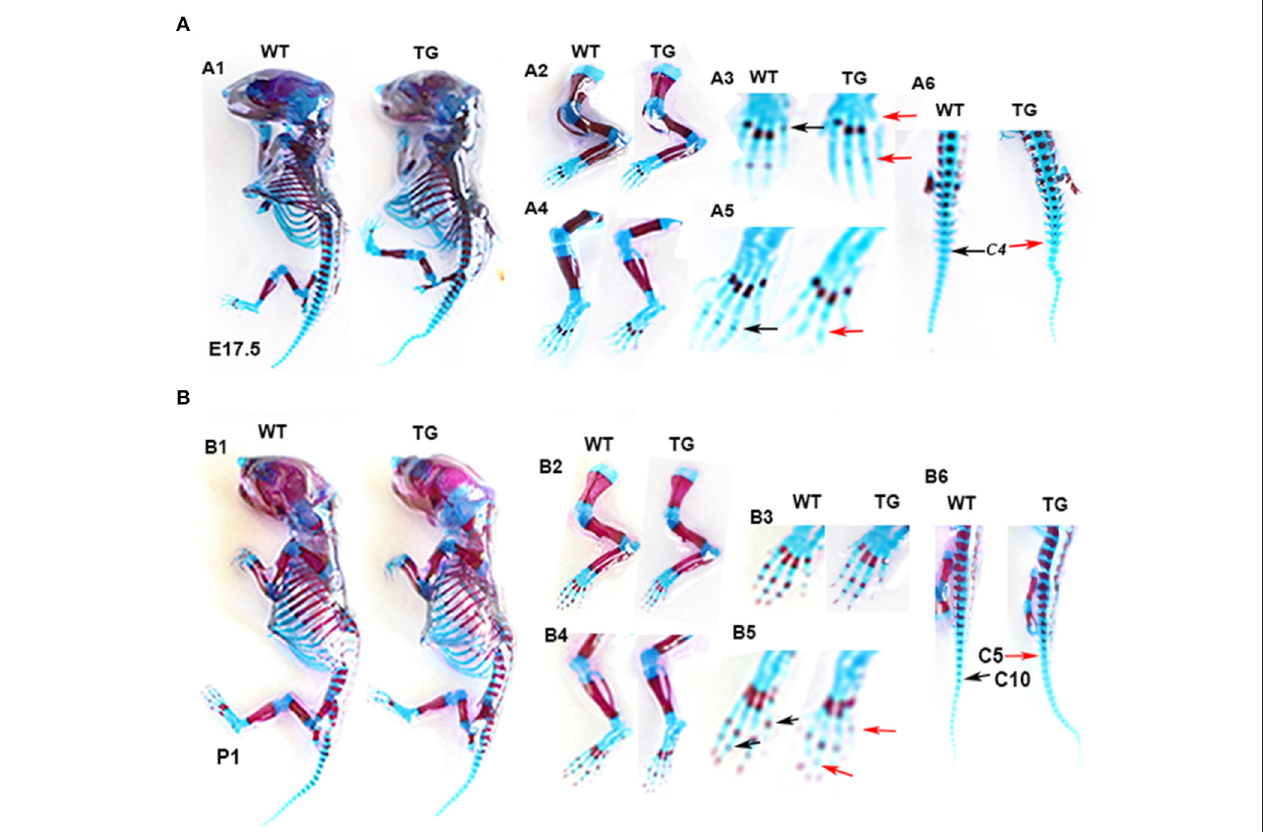
FIGURE 8 | Skeletal phenotype of Col10a1-Tbx5 TG mice. (A) Alcian blue and Alizarin red staining of the mouse skeleton on E17.5. A1: whole skeleton, no difference in Alizarin red staining between TG and WT mice. A2/A3 (zoomed-in pictures of A2): forelimb, no Alizarin red staining in the last phalange of a TG mouse (red arrow), but slight staining in a WT mouse (black arrow). A4/A5 (zoomed-in pictures of A4): hind limb, less Alizarin red staining in the phalanx of a TG mouse (red arrow) compared with a WT mouse (black arrow). (B) Alcian blue and Alizarin red staining of the mouse skeleton on P1. B1: whole skeleton, no difference in Alizarin red staining between TG and WT mice. B2/B3 (zoomed-in pictures of B2): forelimb, no difference between TG and WT mice. B4/B5 (zoomed-in pictures of B4): hind limb, less Alizarin red staining in the metatarsal bones and terminal digits of a TG mouse (red arrows) compared with a WT mouse (black